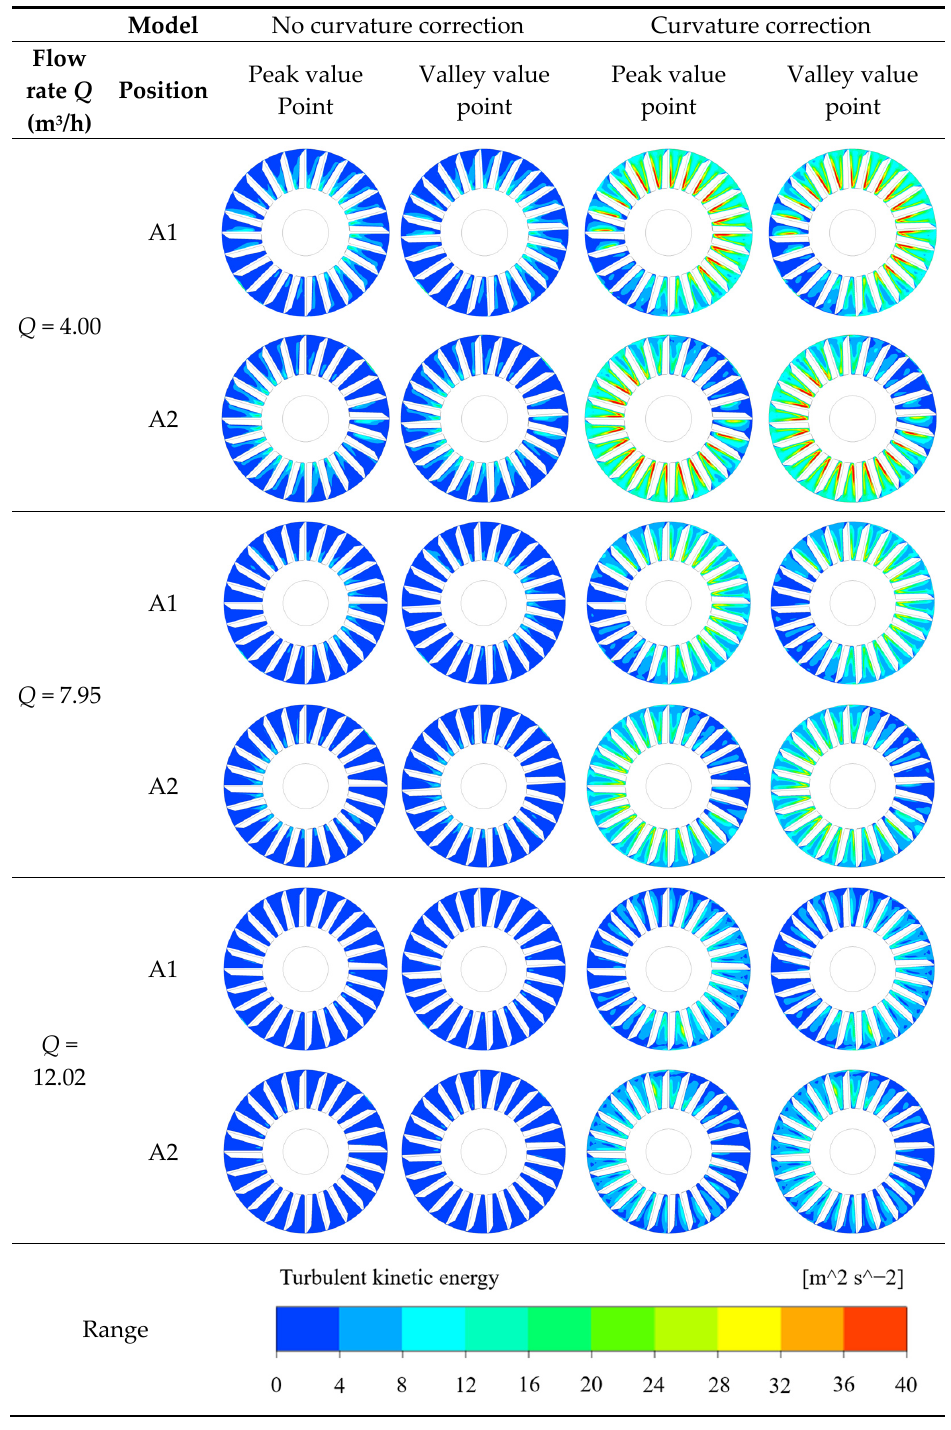
Figure 18. Turbulent kinetic energy distribution based on the DES model with or without curvature correction at A1 and A2, at the peak value point and the valley value point of the head. Curvature correction is very important for the numerical simulation of multistage side channel pump. Whether in vortex analysis, streamline analysis, or turbulent kinetic energy analysis, curvature correction can greatly improve the numerical model of multistage side channel pumps and, to a certain extent, affect the numerical simulation of